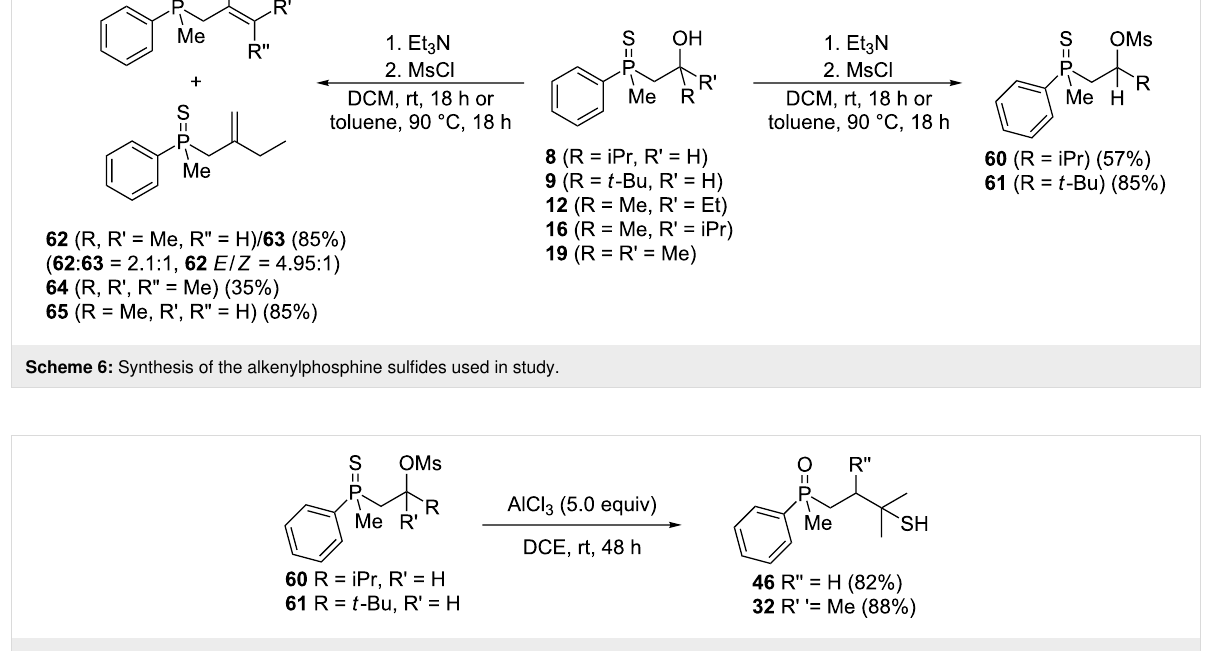
Scheme 7: The reaction of mesylate compounds with Lewis-acidic AlCl 3 .